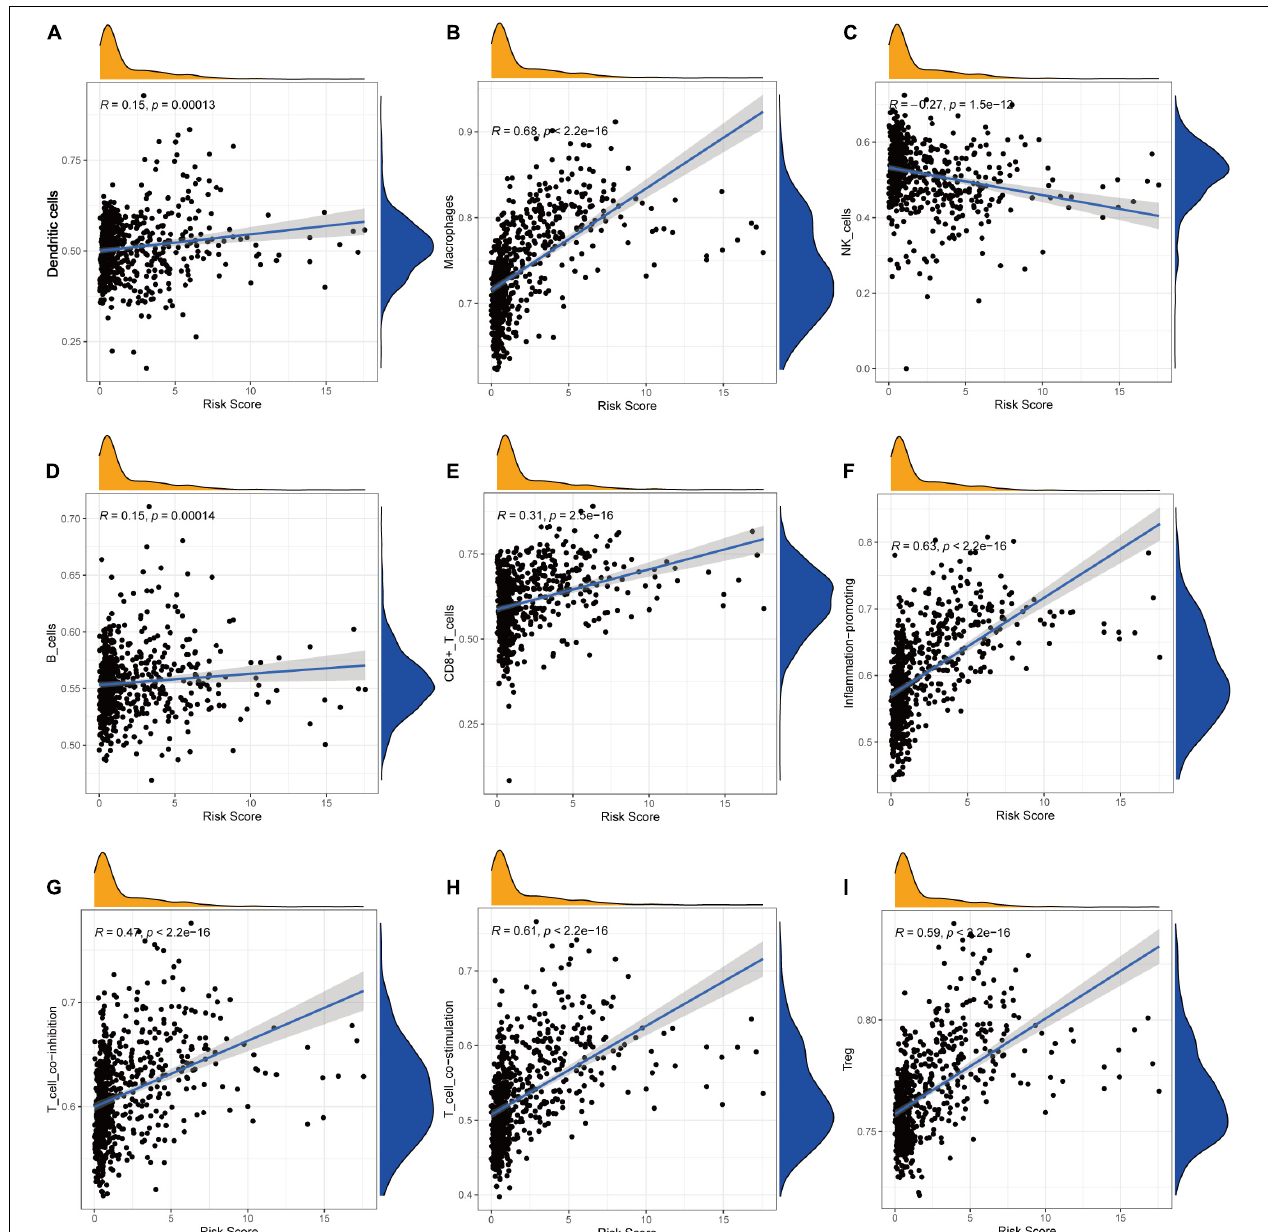
FIGURE 6 | Correlations between the risk score and infiltration abundances of immune cells and immune-related functions. (A) Dendritic cells, (B) macrophages, (C) NK cells, (D) B cells, (E) CD8 + T cells, (F) inflammation promoting, (G) T-cell coinhibition, (H) T-cell costimulation, (I) Treg.